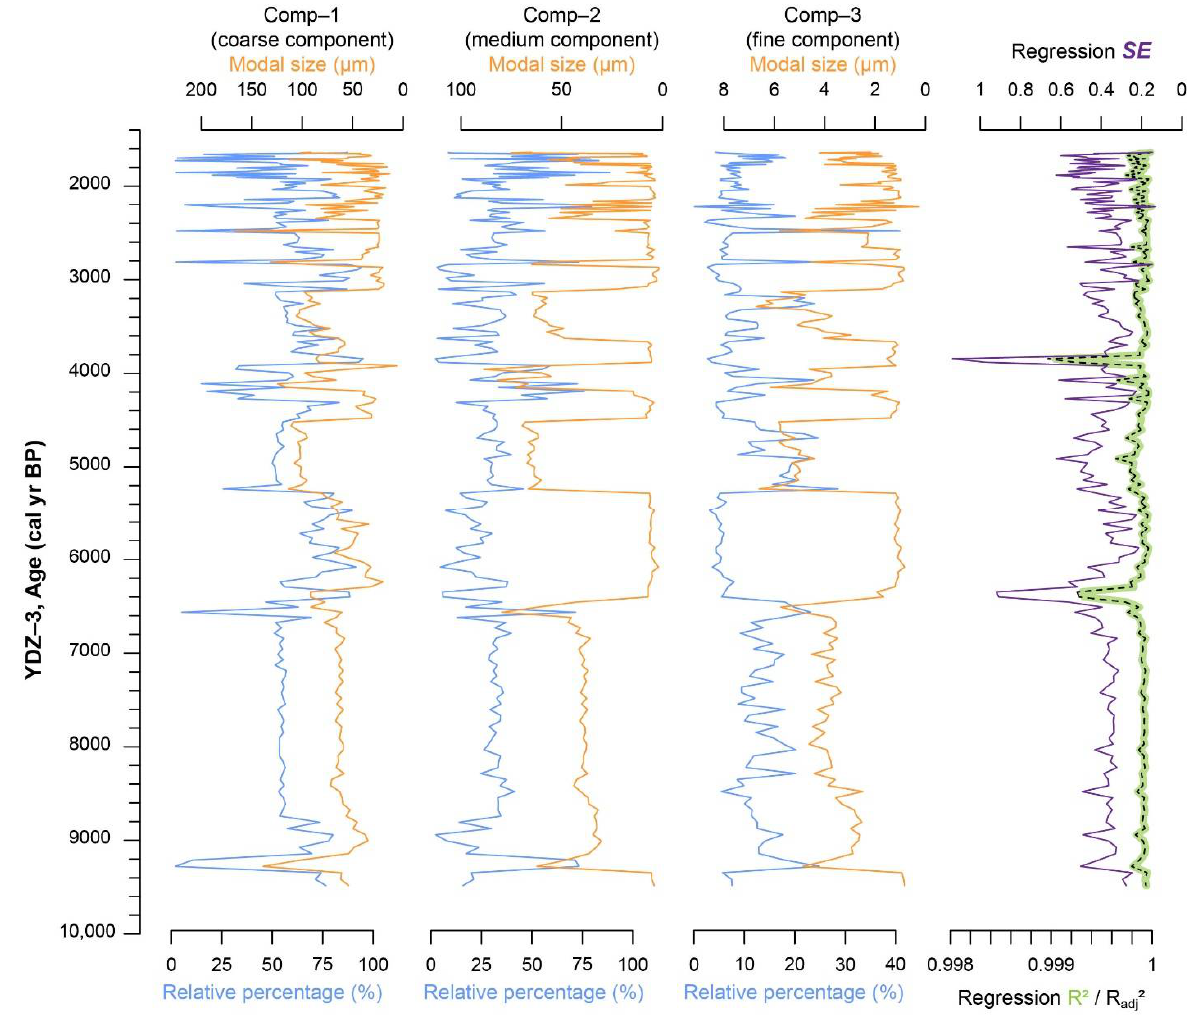
Figure 4. Down-core variation of unmixed components of core YDZ–3 with modes and contents. The right panel shows decomposition R 2 (bold green line), R 2adj (dashed black line), and standard error of the regression ( SE) (thin purple line) were employed for helping choosing the best fit of partitioning estimations. Comp–1, –2, –3 are three components by unmixing.